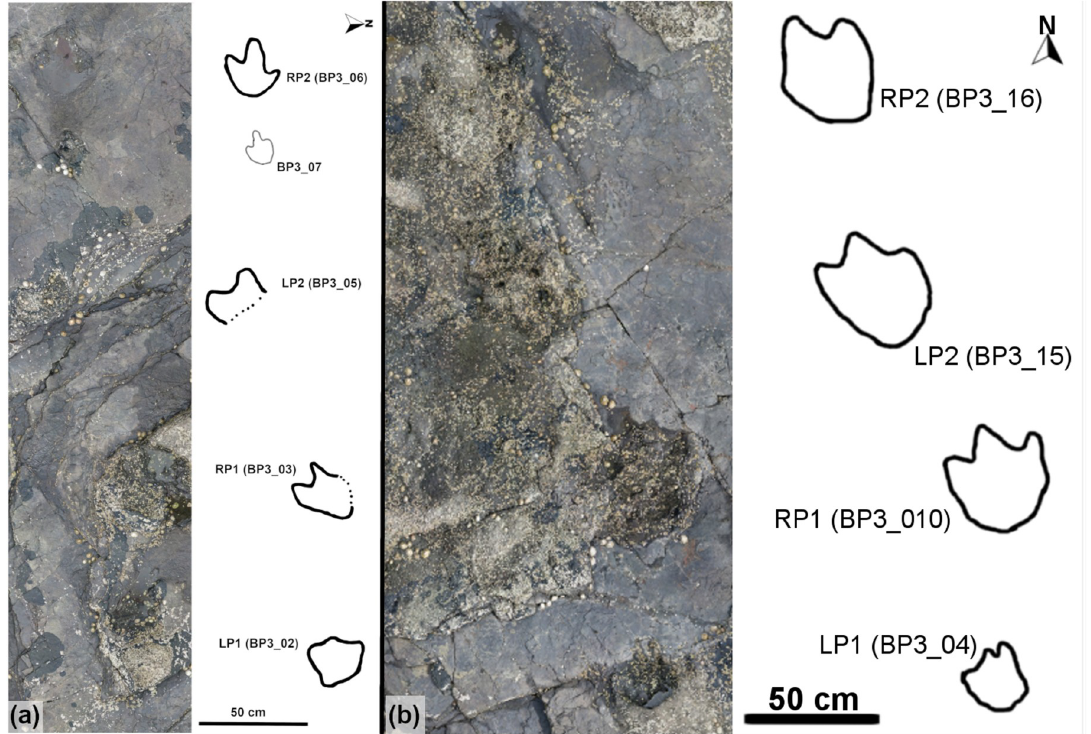
Fig 20. Overview of trackways at BP3. (a) BP1_Twy_01 shown in both the photogrammetric orthophoto and as a line drawing. The trackway consists of four, partially complete, alternating pes impressions where LP denotes the left pes and RP denotes the right pes. LP1 and RP1 are separated from LP2 and RP2 by a break in the track-bearing platform. (b) BP1_Twy_02 shown in both the photogrammetric orthophoto and as an outline drawing. The trackway consists of four pes impressions. LP1 is the most fragmentary track and is only preserved as a deep heel impression. This deep heel persists through the other tracks. The trackway skirts the edge of the overlying beds and, as a result, many of the features of the constituent tracks are obscured. https://doi.org/10.1371/journal.pone.0229640.g020 BP3_Twy_01’s trackmaker hip height was calculated using the average length of the com- plete tracks. The average trackway stride length was 2.04 m while the relative stride length is less than 2.0. Similarly, the smaller stride length of BP1_Twy_02 (1.43 m) and the average of the two most complete tracks (BP3_10 and BP3_15) yield an even lower stride length value. These values indicate that the trackmakers were both moving at a walking pace. We